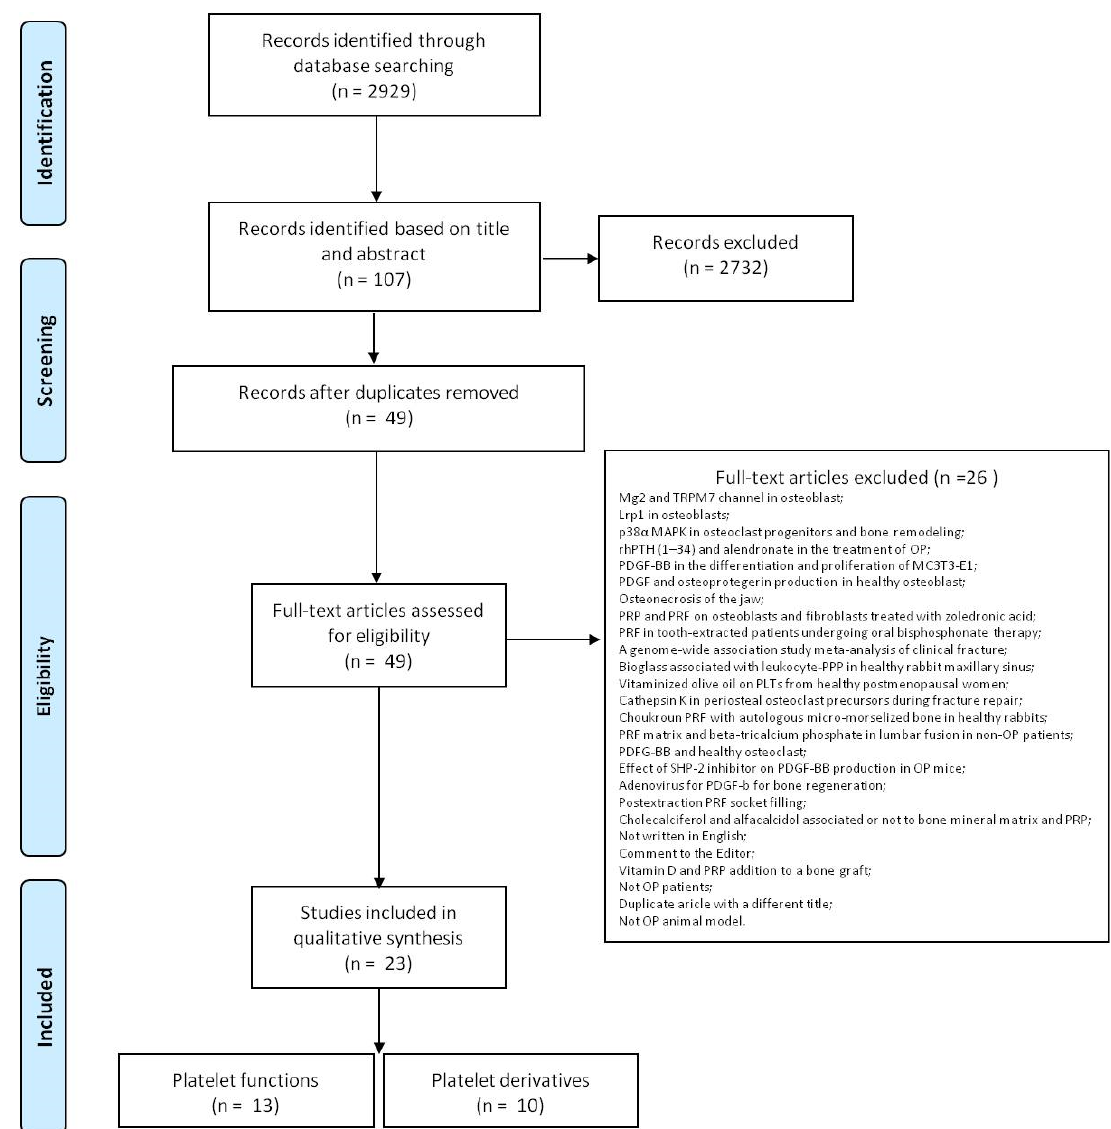
Figure 4. PRISMA flowchart for the selection of studies.